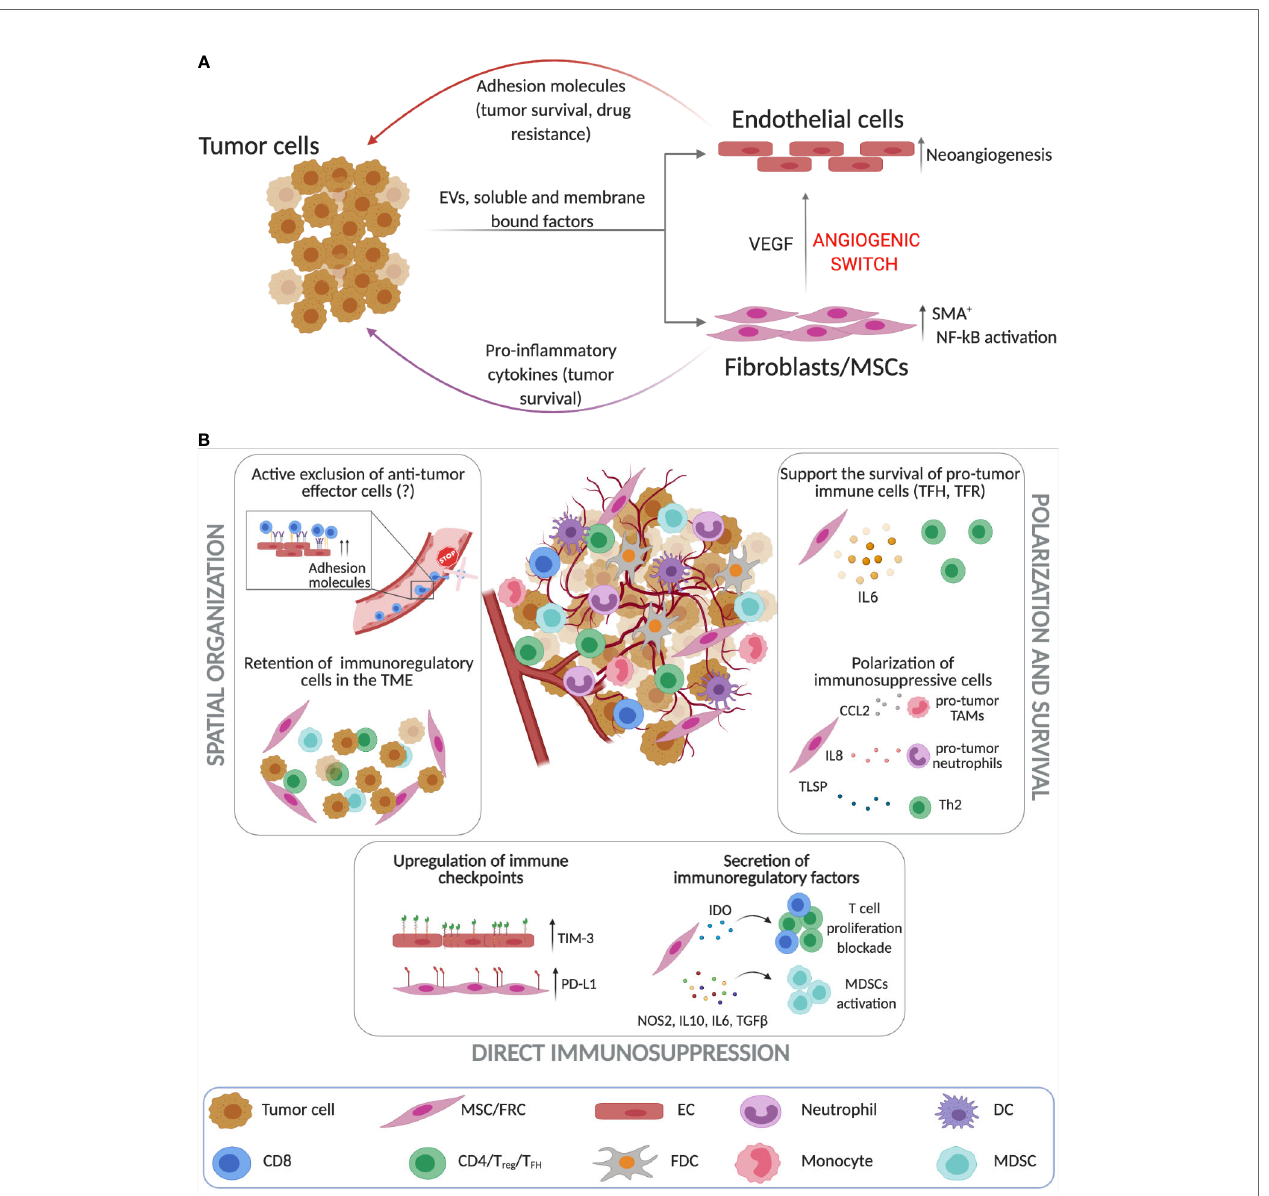
FIGURE 2 | Stroma cells as key players in regulating immune responses in the TME of B cell malignancies. (A) Tumor cells and tissue-resident stroma (endothelial cells (ECs) and FRCs [ fi broblastic reticular cells)/MSCs (mesenchymal stromal cells)] engage into complex bidirectional interactions that promote cancer progression while simultaneously altering the stroma cell phenotype which can then further contribute to resistance to therapy. Tumor B cells induce neoangiogensis and the upregulation of adhesion molecules on ECs (243 – 245, 248, 252). Similarly, lymphoma cells through cell-to-cell contact interactions, secretion of soluble factors and extracellular vesicles (EVs) promote the activation of FRCs and MSCs that contribute to increased tumor survival and neoangiogensis (135, 253 – 255). (B) Unlike solid tumors the investigation of the immunosuppressive roles of stroma cells in the lymphoma TME is still in its infancy. Stromal cells play a crucial role in spatial organization of the TME as they can retain immunoregulatory cells and possibly actively exclude anti-tumor effector cell populations (237, 253, 256 – 261). Additionally, lymphoma ECs and FRCs upregulate immune checkpoints such as TIM-3 and PD-L1 (261, 262) and secrete immunoregulatory factors such as IDO and IL-10 that block T cell proliferation, while activating immunosuppressive cells (263 – 266). FRCs have been also found to drive the survival of pro-tumoral immune subsets such as T FH , T H2 and TAMs (257 – 260). ( Created with